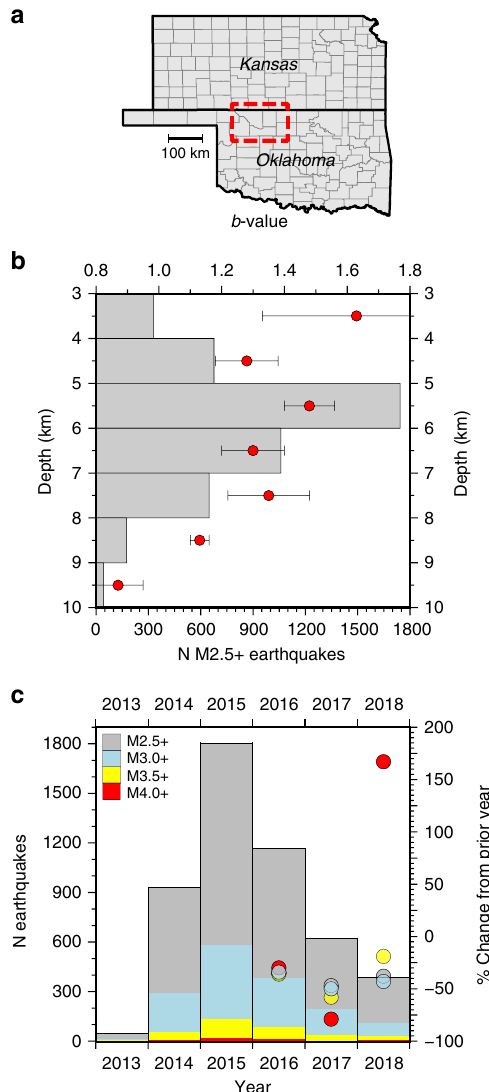
Fig. 5 Earthquake depth-magnitude analysis between 1 Jan 2013 and 31 Dec 2018. a Areal extent of the earthquake catalog within northern Oklahoma and southern Kansas. b Earthquake distribution in 1 km depth intervals (gray bars) with the corresponding Gutenberg-Richter b -value shown as red circles. The b -value systematically decreases beyond 8 km depth indicating that the relative proportion of high-magnitude earthquakes is larger in the 8 – 10 km depth interval. Error bars correspond with two standard errors of the regression slope for each depth interval. c Annual distribution of M2.5 + (gray), M3.0 + (blue), M3.5 + (yellow), and M4.0 + (red) earthquakes, as well as the percent change from the prior year (circles) beginning when